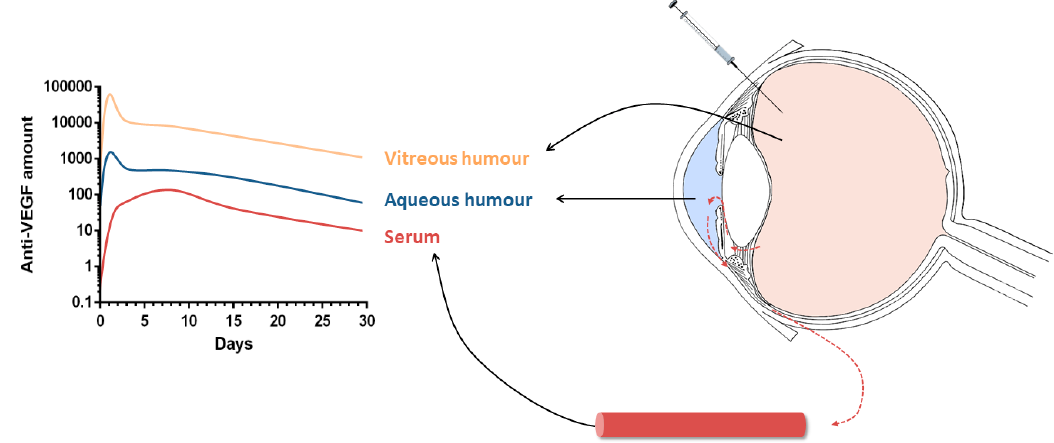
Figure 1. Scheme of the pharmacokinetic profiles after anti-VEGF antibodies intravitreal injection. Only one study has compared the pharmacokinetics of the three anti-VEGF antibodies that were used in clinical practice [19]. Avery et al. compared the systemic exposure and the suppression of VEGF in plasma. Ranibizumab showed the least systemic exposure, whereas bevacizumab presented the highest with a 35-fold increase in AUC as compared to ranibizumab. These differences further increase after the third dose. Aflibercept appears to have the greatest suppression of free plasma VEGF out of the three, with serum concentrations that exceed its IC50 value (0.068 nM) at three hours post-injection and remain above this for seven days. In contrast, ranibizumab mean trough levels remained similar to the baseline [19].